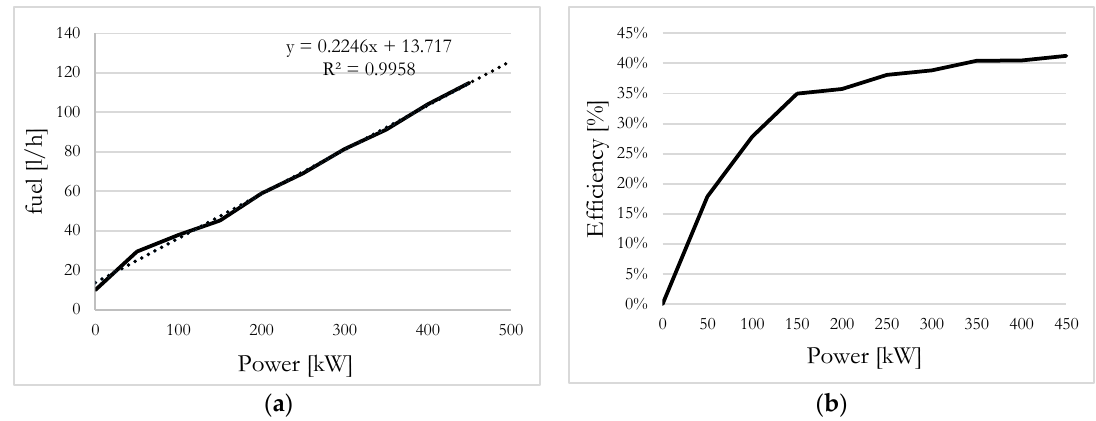
Figure 2. ( a ) Measure of fuel consumption rate for the case study; ( b ) Measure of the diesel generators efficiency for the case